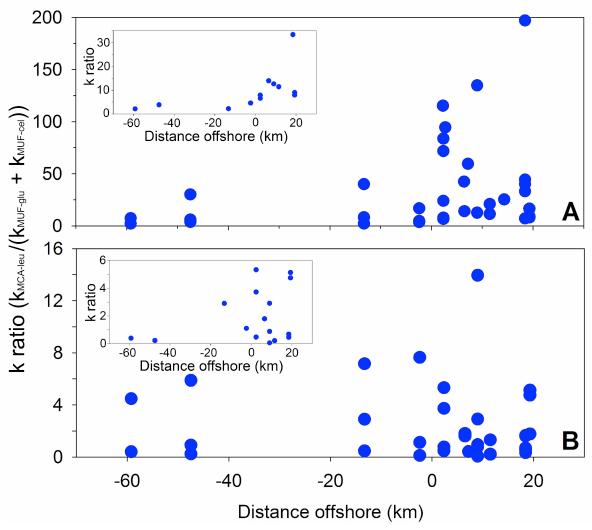
784 Fig. 6. Relationship between the ratio of hydrolysis rate constants (k) k MCA − leu /( k MUF − glu + k MUF − cel ) and distance from the coast (negative distances represent river sampling sites) for the water col- umn ( A ) and surface sediments ( B ). The insets show the winter